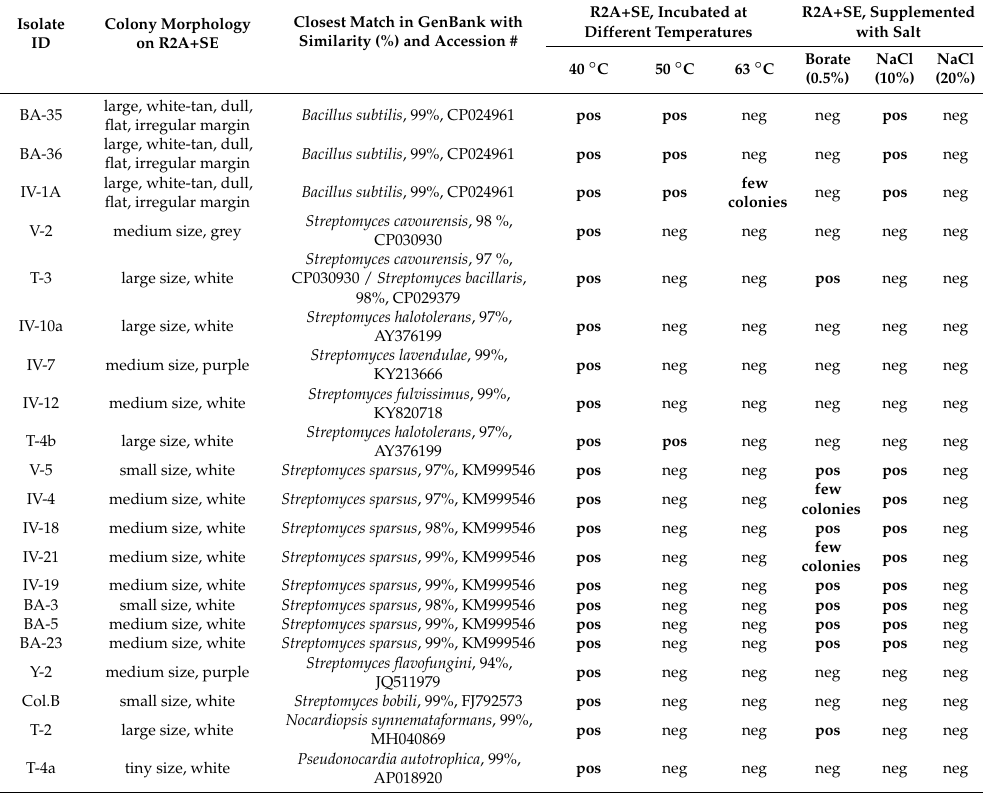
Table 3. Colony morphologies and closest matches in the GenBank nucleotide database, as well as tolerance to increased temperature, borate and NaCl concentrations for all bacterial isolates investigated are